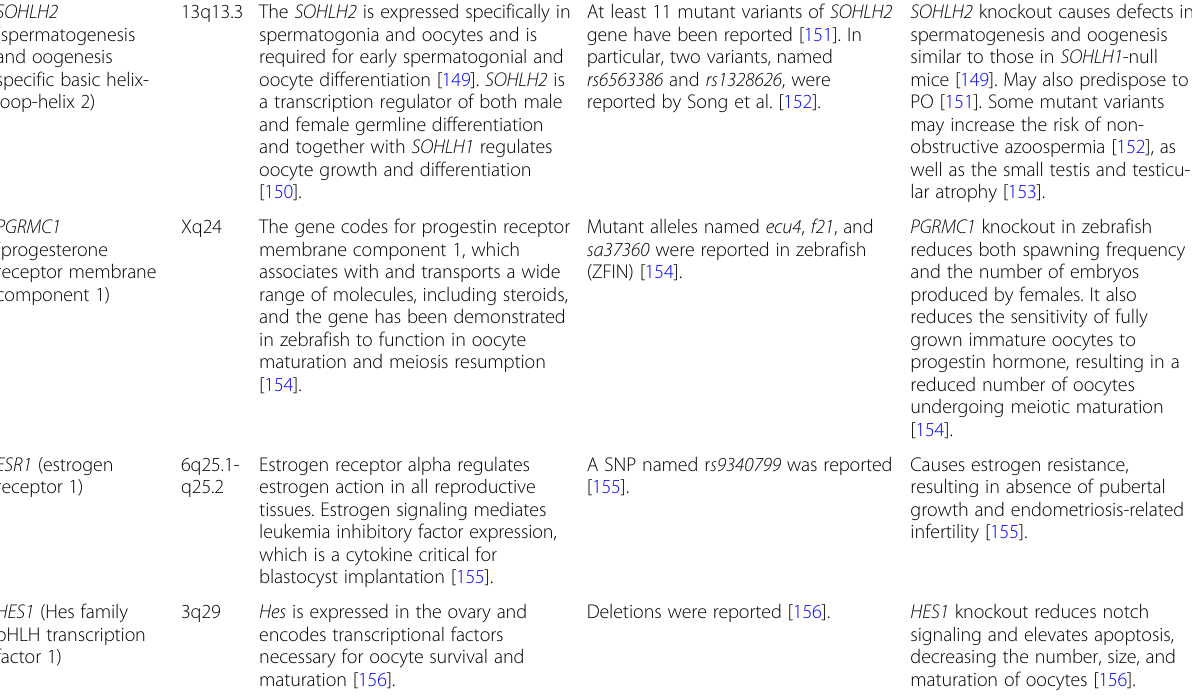
Table 4 Genes predisposing to nonsyndromic ovarian failure (Continued) SOHLH2 (spermatogenesis and oogenesis specific basic